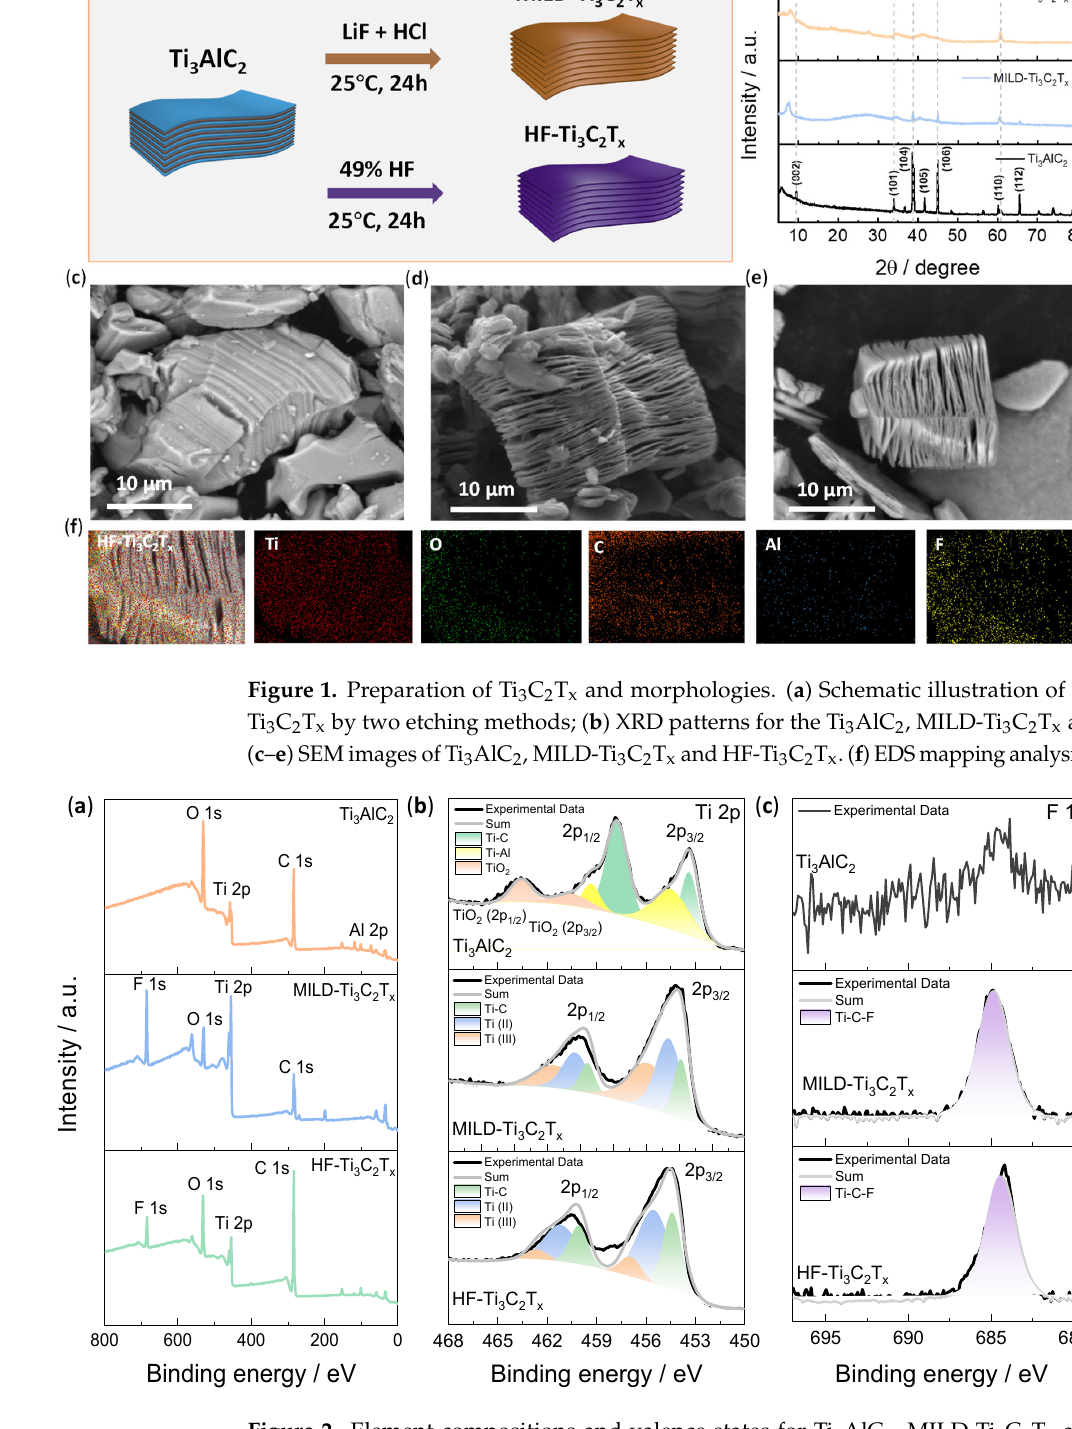
Figure 2. Element compositions and valence states for Ti 3 AlC 2 , MILD-Ti 3 C 2 T x and HF-Ti 3 C 2 T x . ( a ) XPS survey spectra of Ti 3 AlC 2 , MILD-Ti 3 C 2 T x and HF-Ti 3 C 2 T x . ( b ) XPS spectra of Ti 2p for Ti 3 AlC 2 , MILD-Ti 3 C 2 T x and HF-Ti 3 C 2 T x . ( c ) XPS spectra of F 1s for Ti 3 AlC 2 , MILD-Ti 3 C 2 T x , and HF-Ti 3 C 2 T x